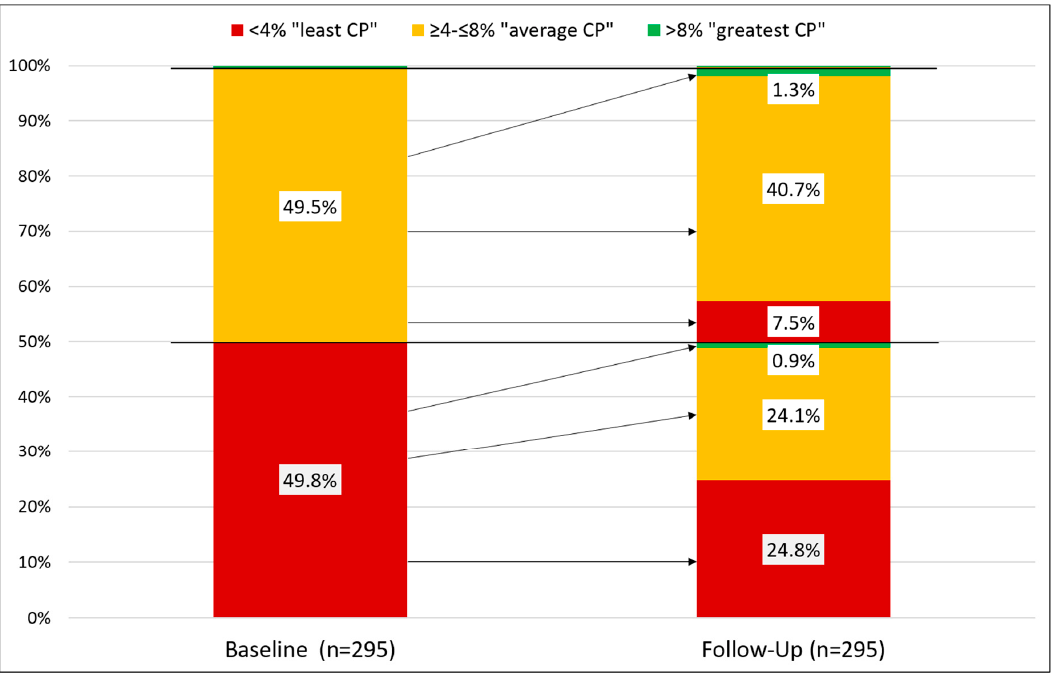
Figure 5. Bar chart to show the change in the categorical omega-3 index between baseline and follow-up ( n = 295). Relative frequencies <5% are not labeled in the illustration for reasons of legibility; due to rounding, the sum of the percentages may deviate from 100%. Arrows indicate the group change from baseline to follow-up.